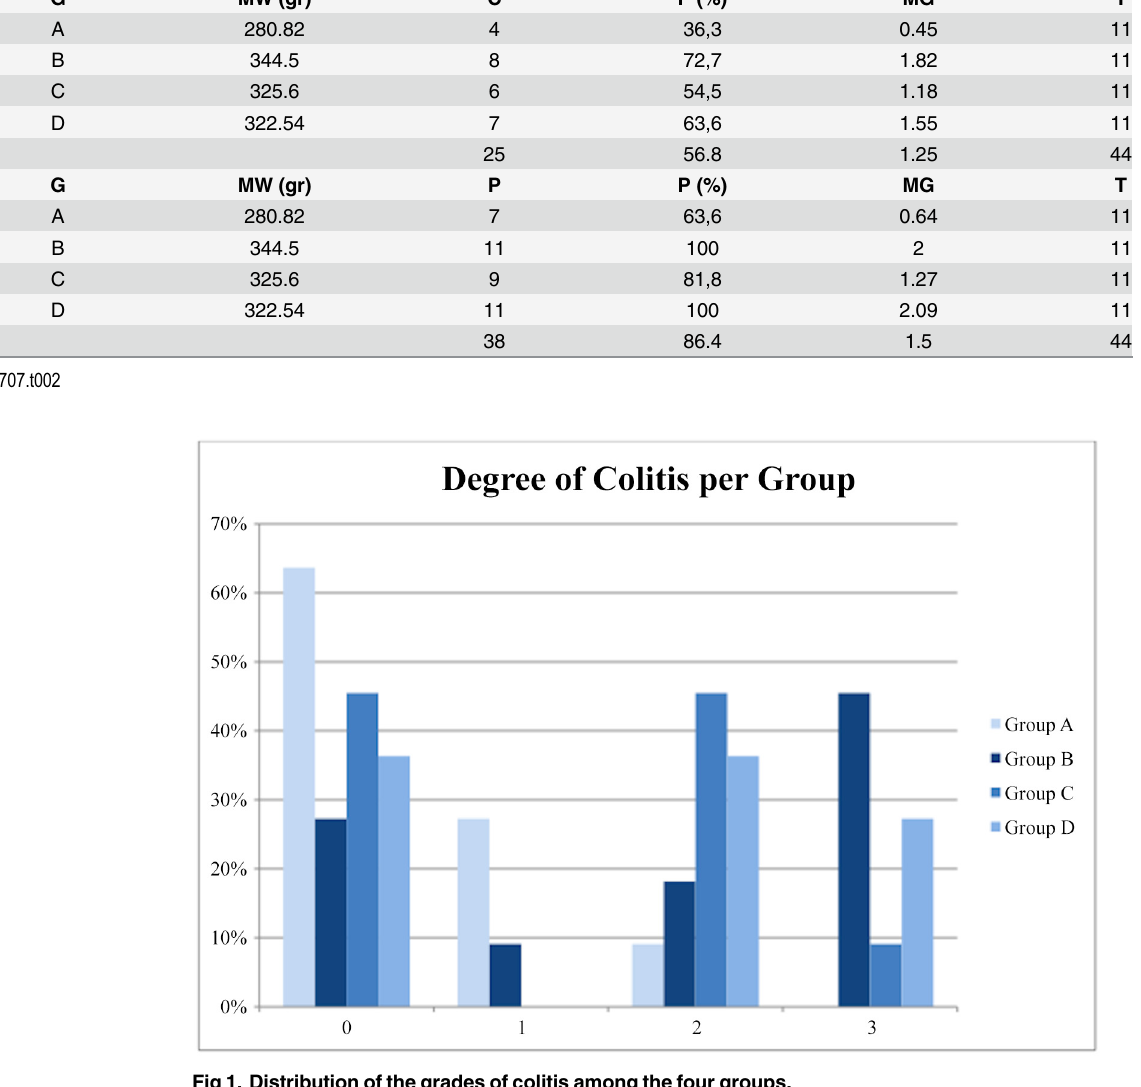
Fig 1. Distribution of the grades of colitis among the four